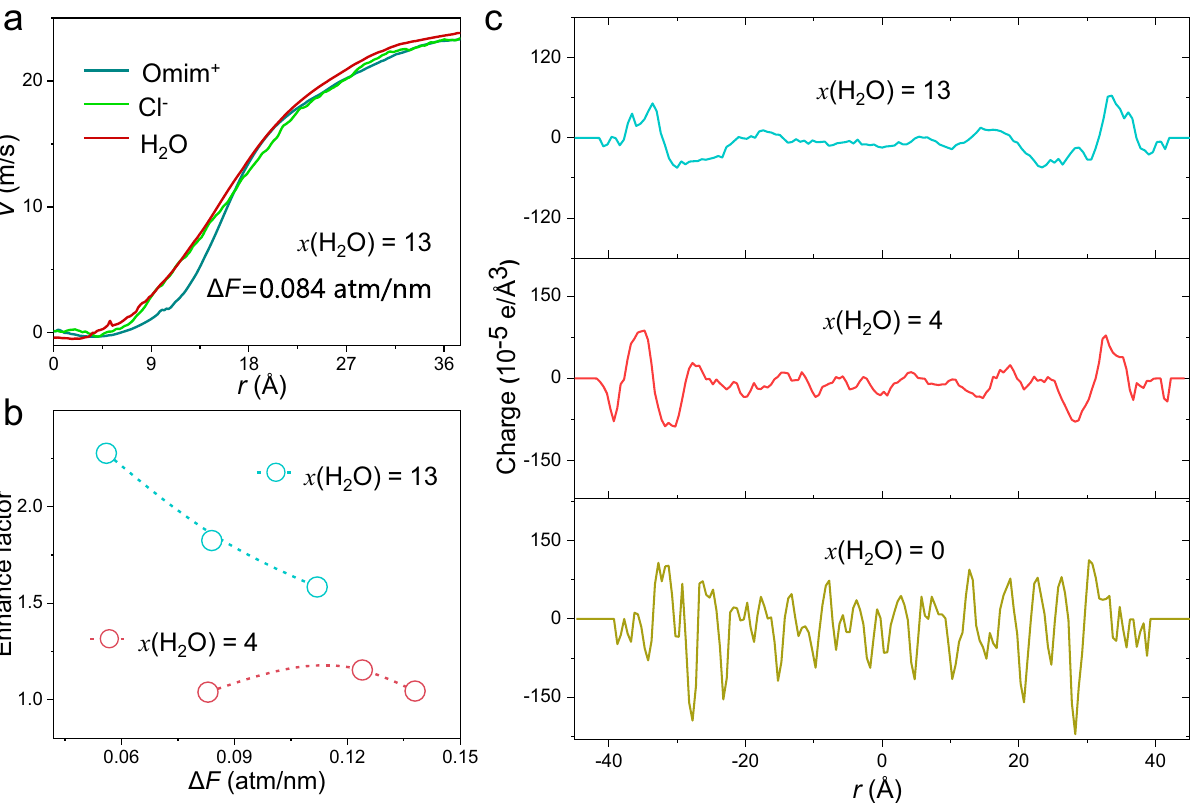
Fig. 6 Flow induced potential difference across PDMS nanowire array. a The velocity distribution of Omim + , Cl − , and H 2 O con fi ned within PDMS walls under pressure gradient of 0.084 atm/nm. b The enhance factor for ILs with x (H 2 O) = 4 and 13 as a function of the pressure gradient. c The charge distribution as a function of distance between the two PDMS layers when x (H 2 O) is 0 (bottom), 4 (middle), and 13